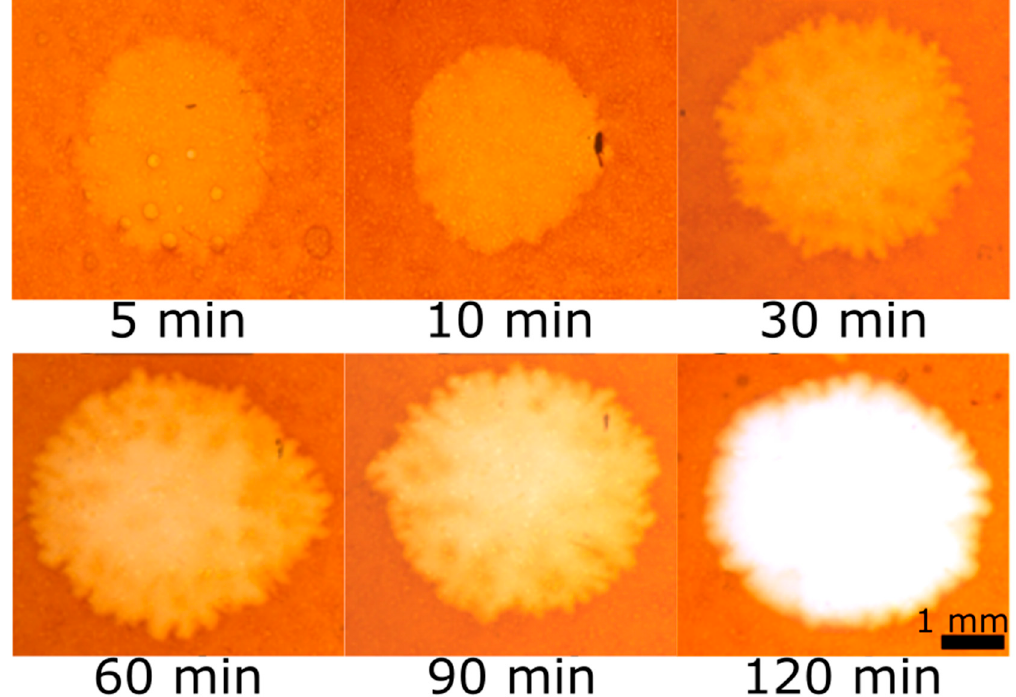
Figure 3. Effect of incubation time. Six different dyed CMC films were subjected to 10 μ L containing 10 μ g of cellulase. The films were incubated at 37 °C for different time periods, between 5 min and 2 h (as indicated under the tiles); then, they were washed and visualized. The halo becomes bigger and brighter with time. Importantly, a halo can be seen within 5 min, validating this method as a real-time visualization of cellulase activity.